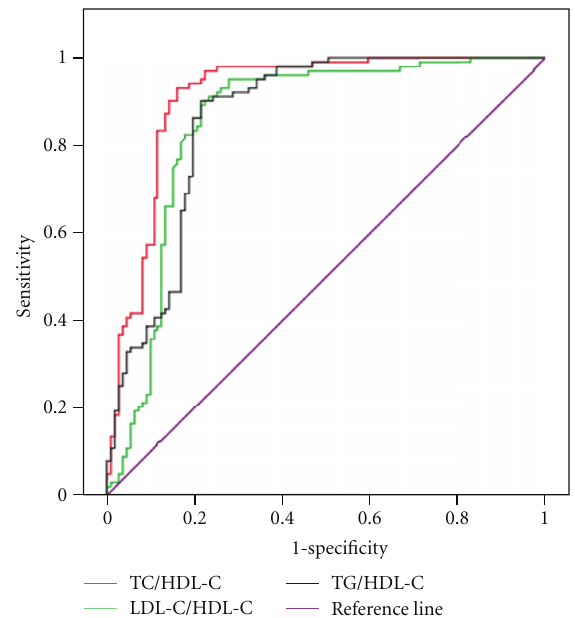
Figure 1: Serum lipoprotein ratios had high sensitivity and speci- ficity for the detection of PCOS with insulin